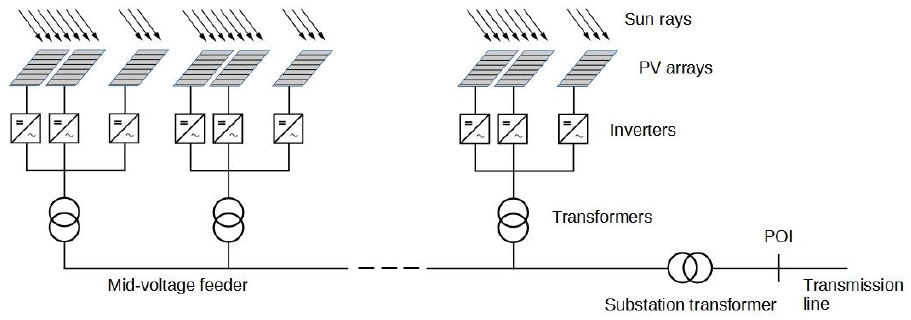
Figure 3. Typical PV power plant topology.